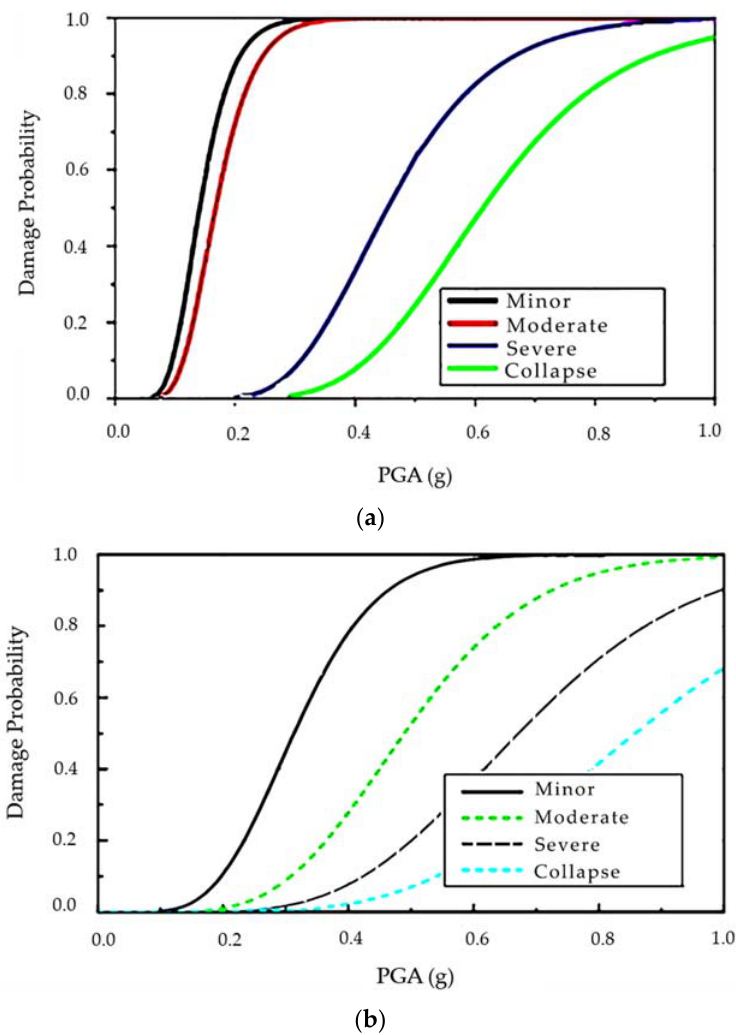
Figure 9. Comparison of the seismic fragility curves of ( a ) the isolated bridge and ( b ) the general bridge.